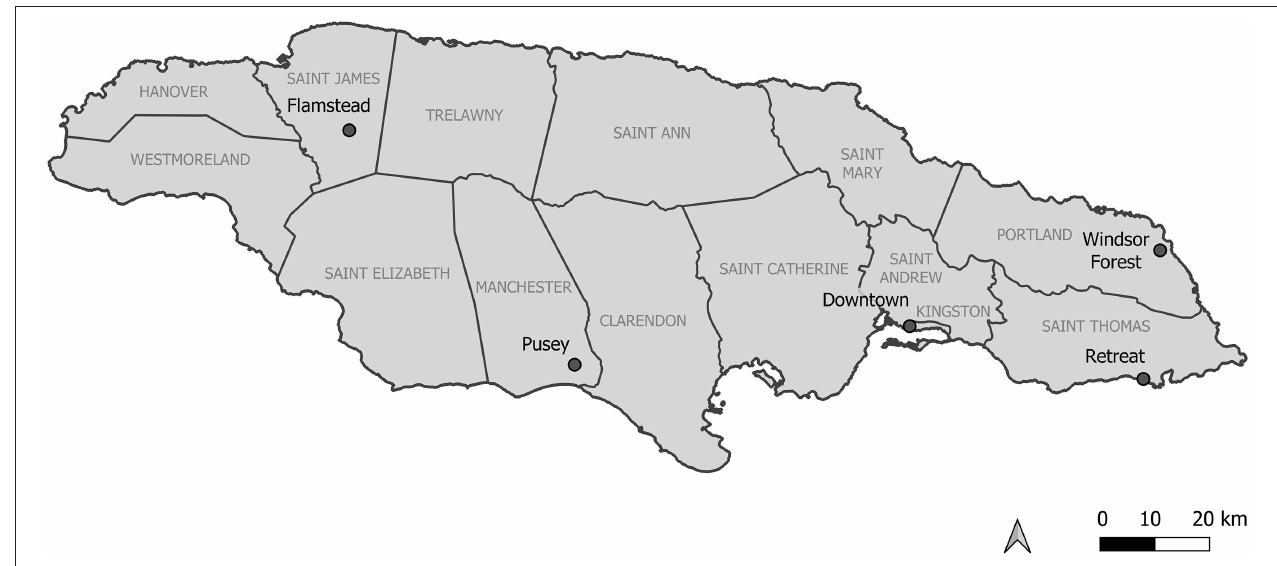
FIGURE 1 | Map of Jamaica with parish boundaries and parish names (light gray). Black dots and black names represent the five communities (and neighboring areas) where ethnobotanical research (interviews and plant collecting) took place (parish name is given between brackets): Flamstead (St. James), Pusey (Manchester), Downtown Kingston (Kingston), Retreat (St. Thomas), and Windsor Forest